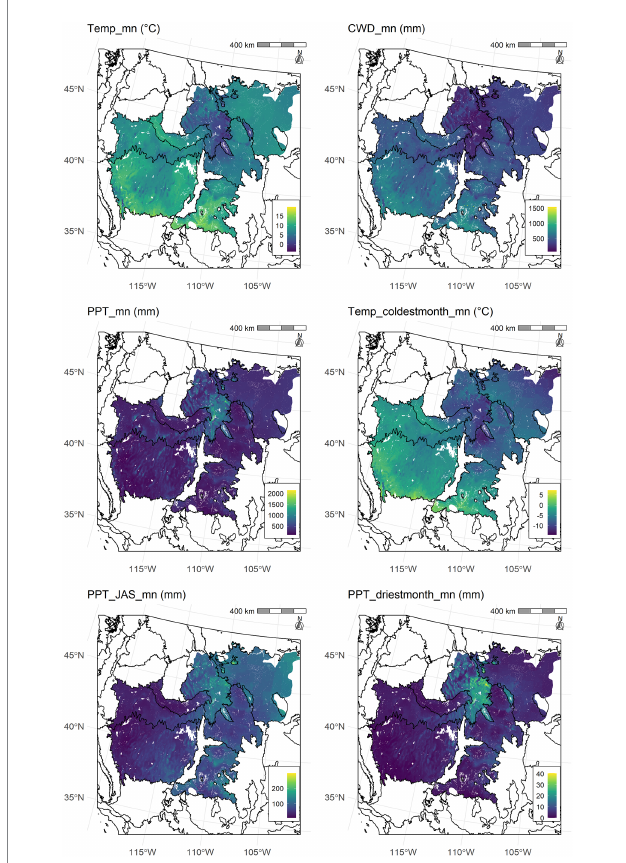
FIGURE 1 Maps of the most highly ranked predictor variables of resilience and resistance for the study area. Black lines indicate Level III EPA ecoregion boundaries (US Environmental Protection Agency [US EPA],